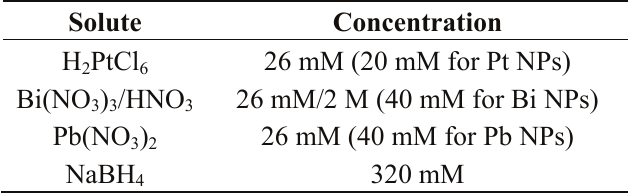
Table 4. The concentrations of metal salts and the reducing agent solubilized in